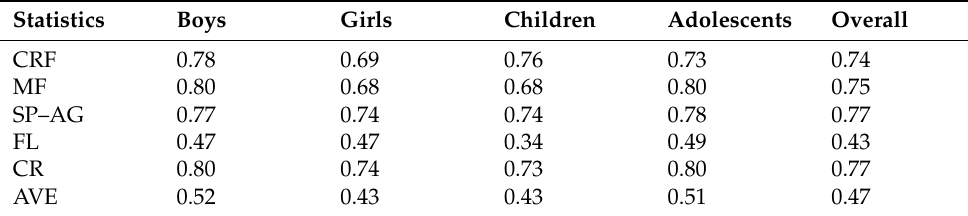
Table 5. Factor loadings, CR and AVE of the IFIS-C in Chinese children and